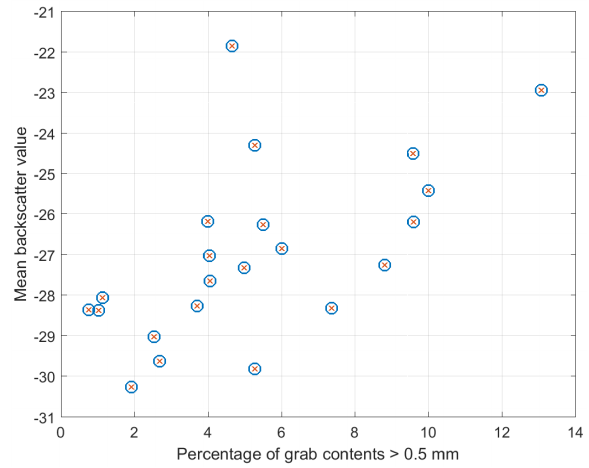
Figure 14. Mean backscatter value of angular response curve (excluded data around nadir) versus percentage of grab contents with grain sizes greater than 0.5